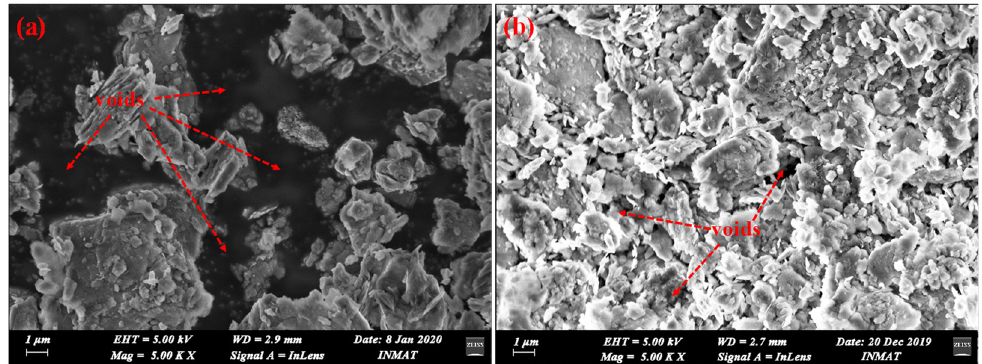
Figure 2. Microstructure of various samples: ( a ) raw coal gangue; ( b ) CACG. It can be seen from Figure 1 that coal gangue is primarily composed of kaolinite (K), illite (I), quartz (Q), chlorite (C), and muscovite (M). The kaolinite peaks nearly disappeared